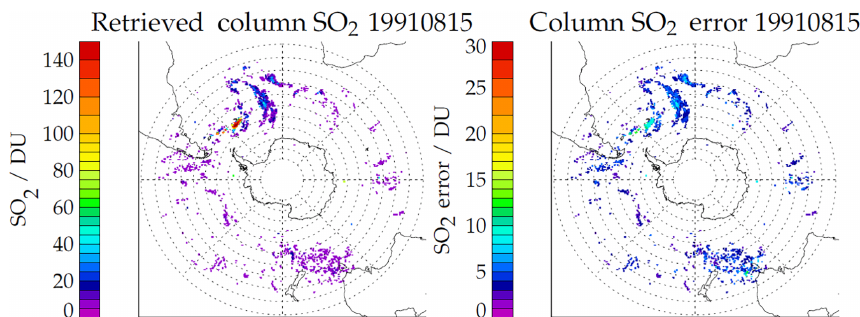
Figure 6. Retrieved SO 2 columns for 15 August 1991, and retrieved error for orbits that day. Erupted SO 2 from the start of the eruptive phase (from 8 August 1991) is evident ahead of the larger plume emitted on 15 August. Data are screened at the 2 σ level (5.4DU).